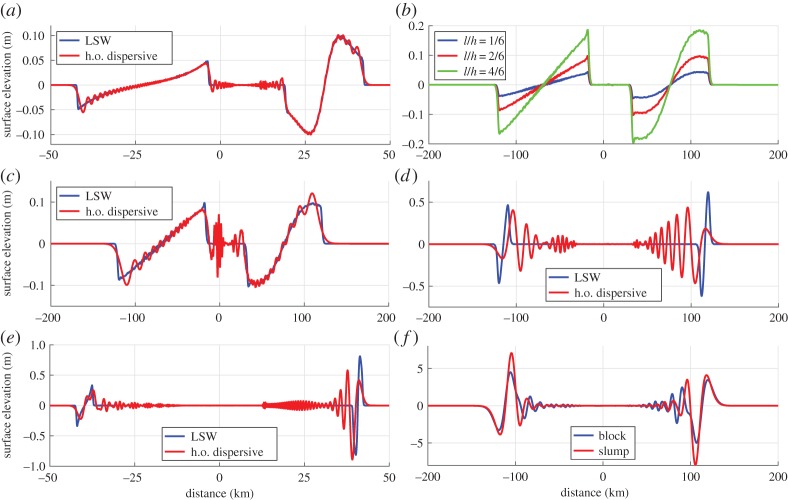
Plane evolution of waves generated by rightwards moving blocks on a constant depth sea-floor. In all cases, the landslide motion has terminated, and the relative landslide thickness is S=d/h=0.067. (a) Rectangular block source, landslide and depth parameters ℓ/h=1.67, tb=256 s and um=15.3 m s−1, Fr=0.40 (h=150 m) and a0= 0.06 m s−2, LSW simulation (blue) and higher order dispersive simulation (red). (b) LSW model using a rectangular block source, landslide and depth parameters tb=256 s, um=15.3 m s−1, Fr=0.13 (h=1500 m), a0=0.06 m s−2, for ,  and , respectively. (c) Rectangular block source with the landslide and depth parameters , tb=256 s and um=15.3 m s−1, Fr=0.13 (h=1500 m) and a0=0.06 m s−2, LSW simulation (blue) and higher order dispersive simulation (red). (d) Rectangular block source with the landslide and depth parameters, , tb=32 s and um=15.3 m s−1, Fr=0.13 (h=1500 m) and a0= 0.48 m s−2, LSW simulation (blue) and higher order dispersive simulation (red). (e) Rectangular block source, landslide and depth parameters ℓ/h=1.67, tb=32 s and um=15.3 m s−1, Fr=0.40 (h=150 m) and a0=0.48 m s−2, LSW simulation (blue) and dispersive simulation (red). (f) Higher order dispersive simulation with the landslide and depth parameters ℓ/h=10.67, tb=32 s and um=15.3 m s−1, Fr=0.13 (h=1500 m) and a0= 0.48 m s−2, rectangular block (blue) and slump (red).